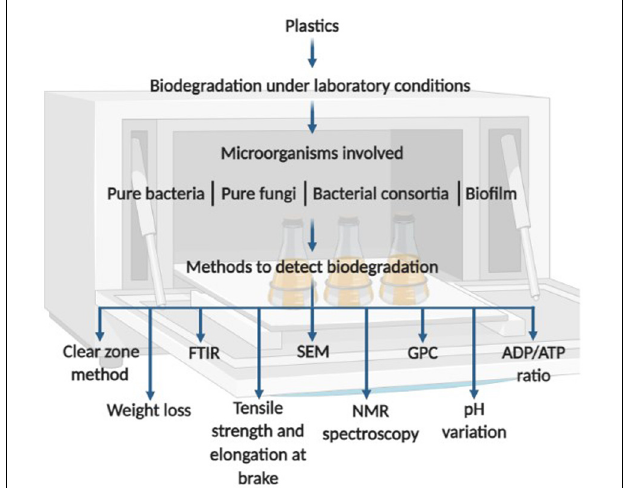
FIGURE 6 | Methods used to detect plastics biodegradation under laboratory conditions. FTIR, Fourier Transform Infrared Spectroscopy; SEM, Scanning Electron Microscopy; NMR, Nuclear Magnetic Resonance spectroscopy; GPC, Gel Permeation Chromatography; ADP/ATP, adenosine diphosphate/adenosine triphosphate